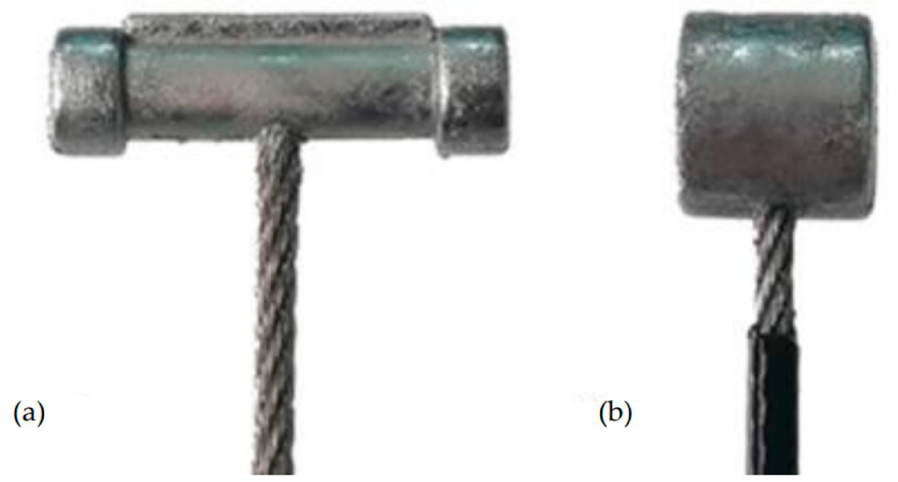
Figure 5. Types of cable ends injected in the line BX726: ( a ) model 75, ( b ) model 70.